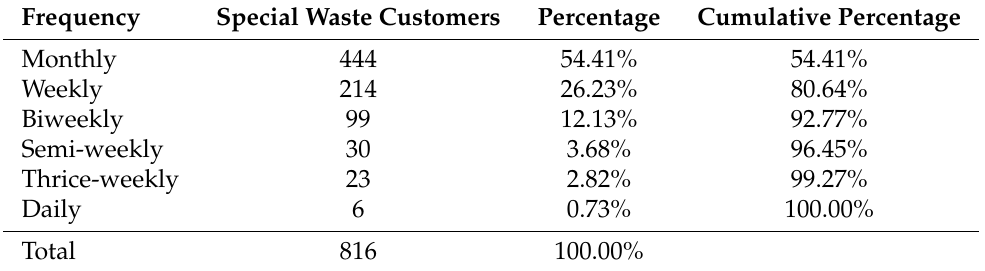
Table 1. Customer visit frequency.